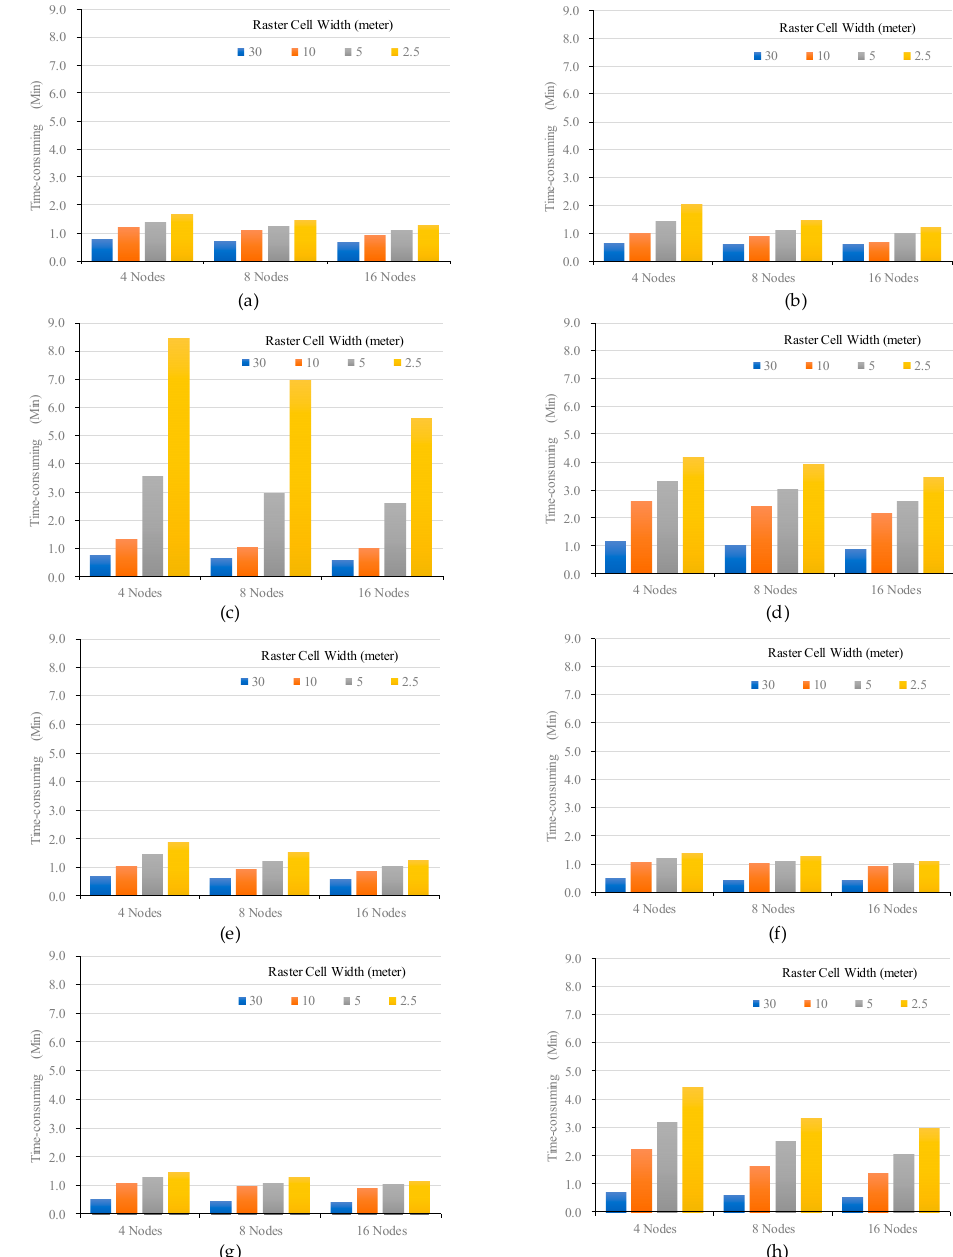
Figure 13. Time-consumption with different calculation tasks. ( a ) R factor; ( b ) K factor; ( c ) LS factor; ( d ) B factor; ( e ) E factor; ( f ) T factor; ( g ) g factor; ( h ) model A .